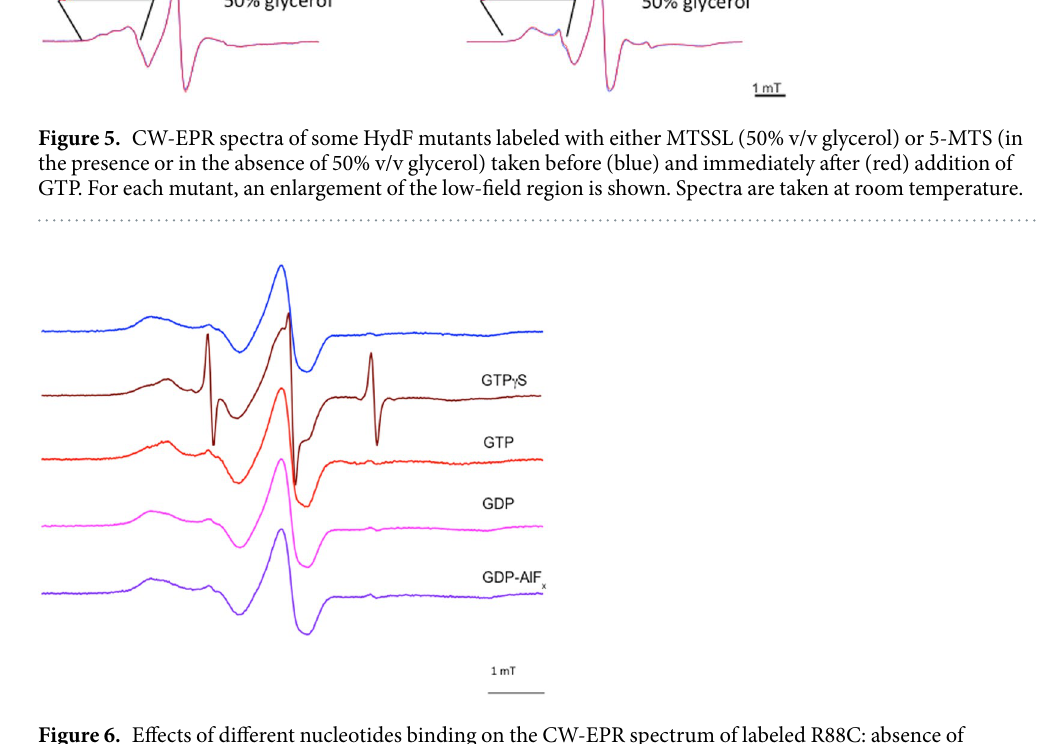
Figure 6. Effects of different nucleotides binding on the CW-EPR spectrum of labeled R88C: absence of nucleotides (blue), in the presence of non-hydrolysable GTP analogue (brown), GTP (red), GDP (magenta) and GDP-AlF x